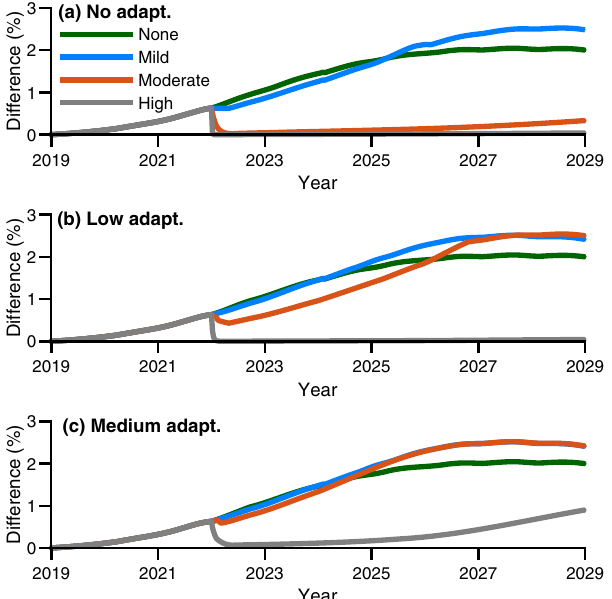
Fig. 6 Adaptive capacity vs median reduction in crown-of-thorns star fi sh (CoTS) catch-per-unit-effort rates (CPUE, CoTS.min − 1 ). The median impact monthly manual control makes across all sub-reef management sites expressed in terms of the difference in catch-per-unit-effort rates (CPUE) between control and no control over a 10-year projected period. Different line colours correspond to different modelled levels of accumulated thermal stress experienced by corals. The green curve corresponded to no stress (DHWs = 0), the blue curve corresponded to mild stress (DHW = 4), the orange curve corresponded to moderate stress, (DHWs = 7), and the grey curve corresponded to high accumulated thermal stress (DHWs = 10). Figure panels vary in terms of modelled coral adaptive and acclimation capacity. a no adaptive and acclimation capacity ( A ¼ 0). b Low adaptive and acclimation capacity ( A ¼ 2 : 5). c Medium adaptive and acclimation capacity ( A ¼ 5). Increasing levels of accumulated thermal stress reduced CoTS catch rates across different adaptive and acclimation capacities. Mean was of similar dynamics but attained higher difference values. Source data (model outputs)